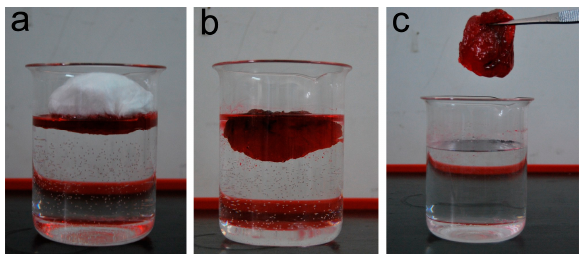
Figure 9. Optical images of recovery of motor oil (colored with oil red O) from water by raw PLA fiber. ( a ) Motor oil-water mixture; ( b ) oil being absorbed by fibrous sorbent; ( c ) complete separation of motor oil from water.